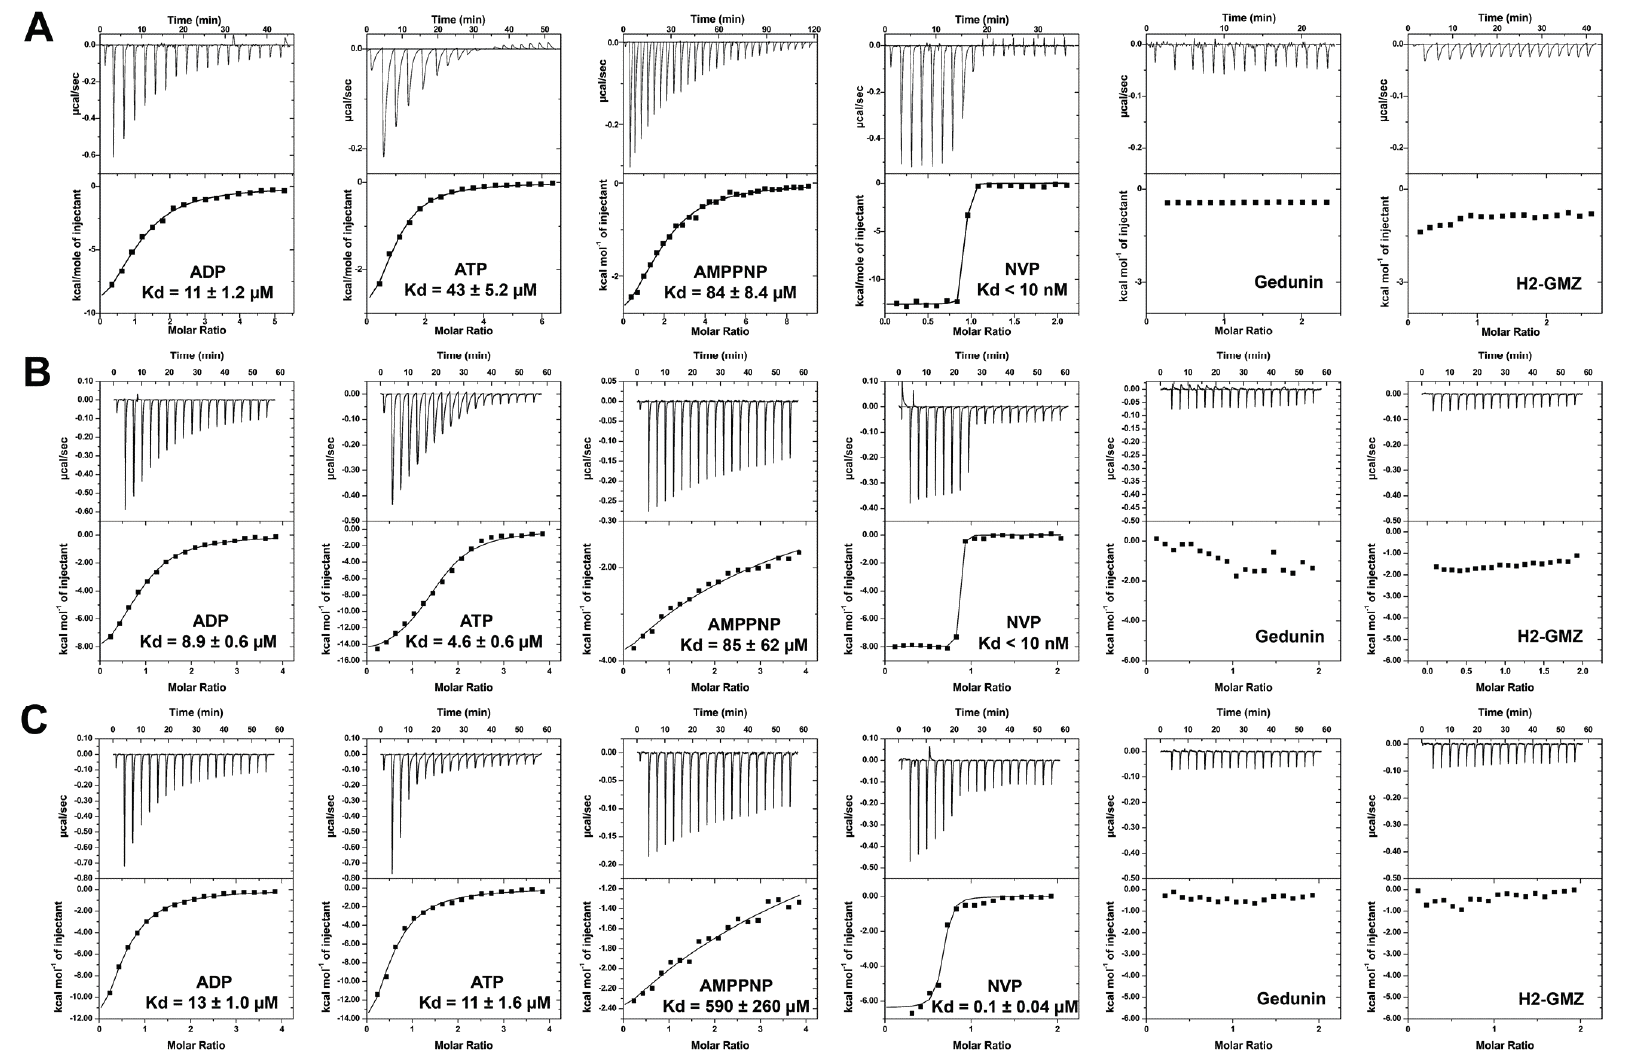
Figure 3. Interaction of Hsp90 β proteins with nucleotides and reported inhibitors determined by ITC. Shown are the results of titrations experiments for small molecule ligands with Δ Hsp90 β ( A ); full-length Hsp90 β ( B ); and CK2-phosphorylated Hsp90 β ( C